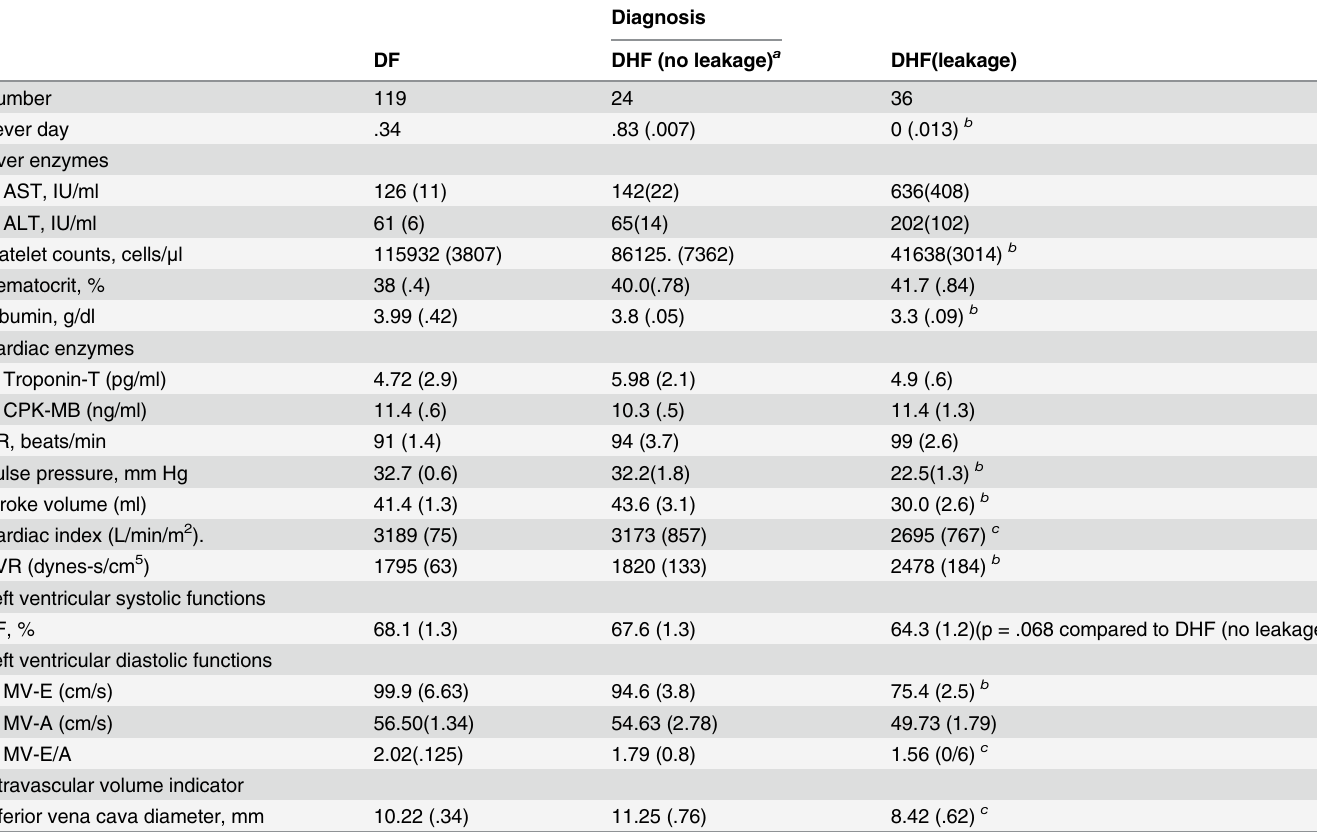
Table 2. Laboratory findings and cardiac function measurements on the first study day in subjects with dengue.